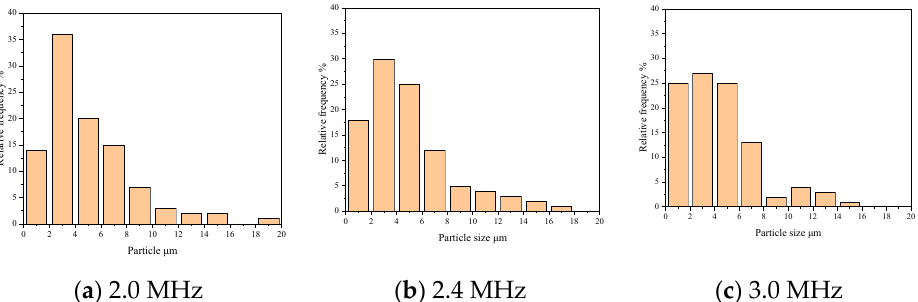
Figure 8. Histogram of frequency particle size distribution. ( a ) is the atomization frequency of 2.0 MHz; ( b ) is the atomization frequency of 2.4 MHz; and ( c ) is the atomization frequency of 3.0 MHz.